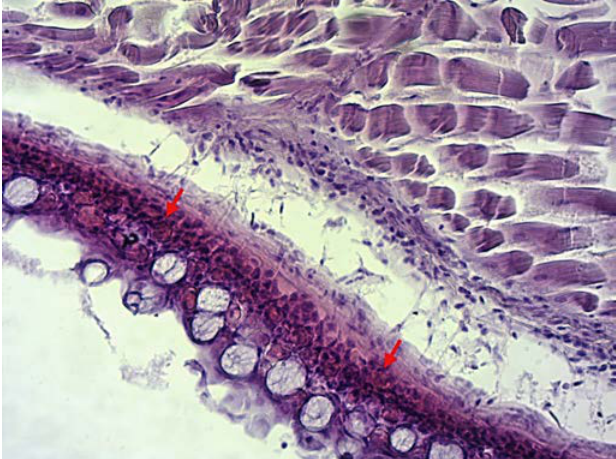
Figure 2. Haemorrhages in subcutaneous tissue. Figure showing section through the subcutis and musculature tissue. Arrows show area of haemorrhages. (H&E, magnification 20×).